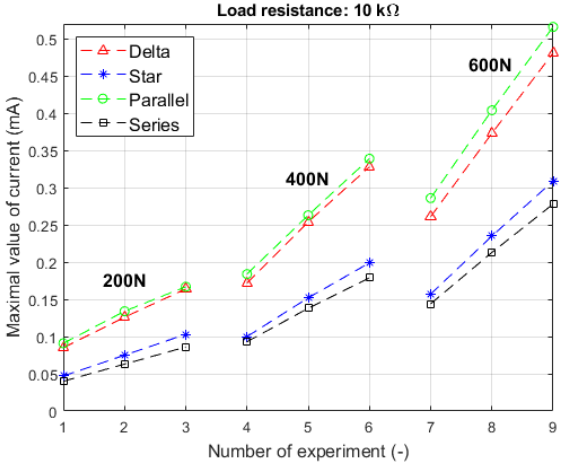
Figure 12. Comparison of maximal values of current for MFC arrays.